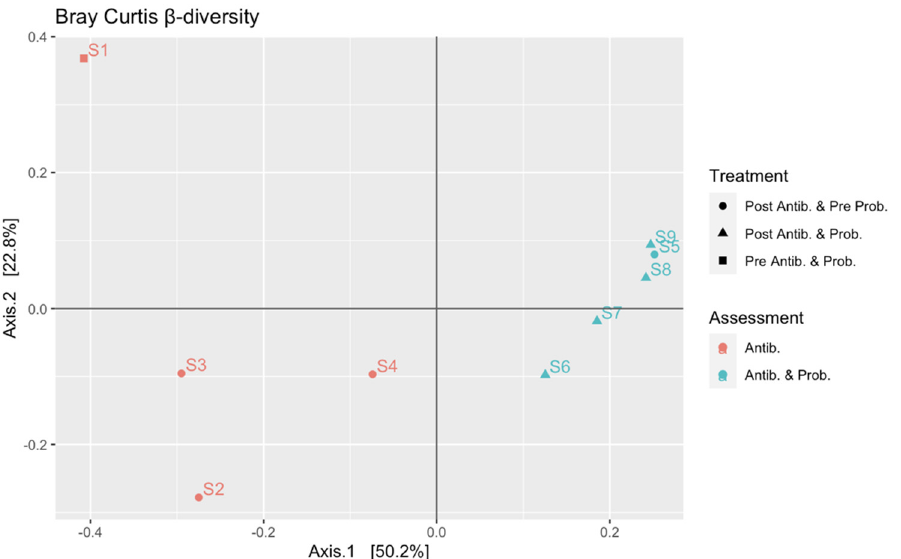
Figure 3. Beta diversity rarefaction based on Bray–Curtis distance metric using “plot_ordination”. Shapes indicate the type of treatment: circles are related to samples collected after antibiotic treatment and before the probiotic supplementation; triangles are related to samples collected after antibiotic treatment and probiotic supplementation; squares are related to samples collected before antibiotic treatment and probiotic supplementation. Colors indicate the two phases of the study: salmon orange is related to samples S1–S4 collected during the first month of life and associated with antibiotic treatment; turquoise is related to samples S5–S9 collected at 4 months of life and associated with antibiotic treatment and probiotic supplementation.